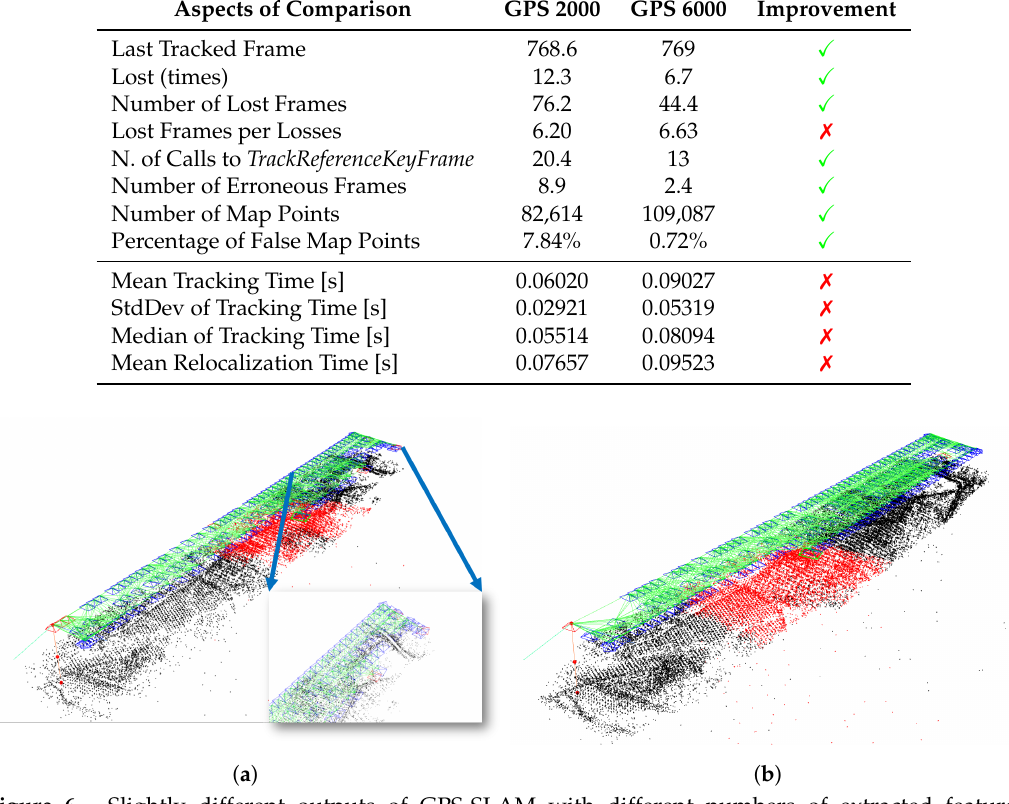
Figure 6. Slightly different outputs of GPS-SLAM with different numbers of extracted features. ( a ) GPS-SLAM with 2000 features. ( b ) GPS-SLAM with 6000